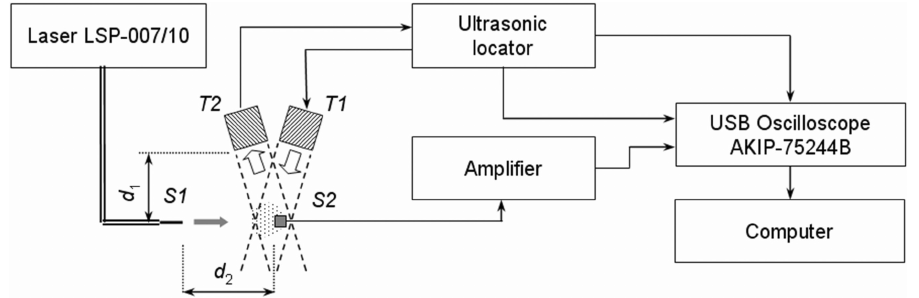
Fig. 1. Experimental setup for detection of bubbles.